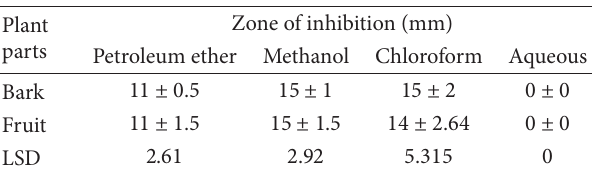
Table 7: Zone of inhibition produced by extracts of different parts of C. ambrosioides against A.